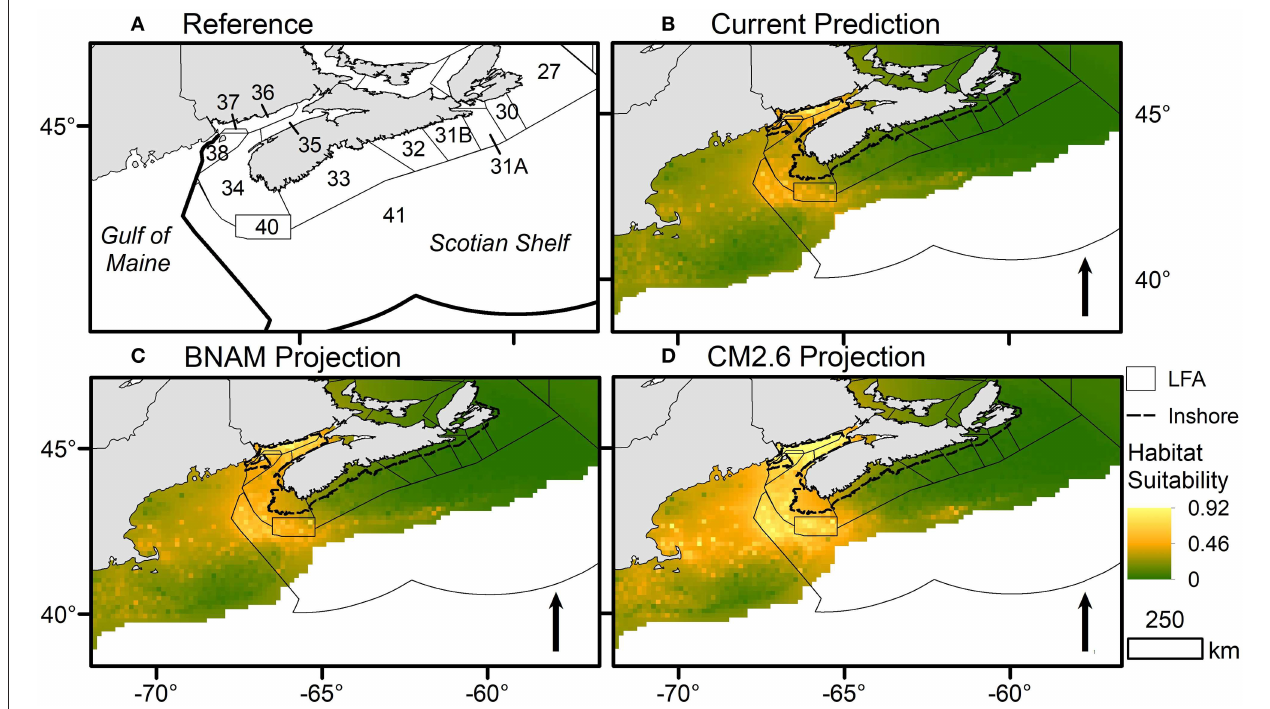
FIGURE 3 | Current and projected habitat suitability maps for American lobster (Homarus americanus ), based on measured and projected ocean temperatures. Habitat suitability is measures on a 0–1 scale, where 0 = low likelihood of the species being present and 1 = a high likelihood of species presence. (A) Reference map with Lobster Fishing Areas (LFAs) labeled. (B) Current prediction for habitat suitability distribution modeled using temperature, depth, season, year, and location from research vessel (RV) survey data. (C) Habitat suitability modeled using the same formula as the current prediction, but projected temperatures from the BNAM ocean forecast model instead of measured temperatures. (D) Habitat suitability modeled using the same formula as the current prediction, but projected temperatures from the CM2.6 ocean forecast model instead of measured temperatures. The black dashed line along the coast of Nova Scotia delineates the extent of the inshore fishery where no data are